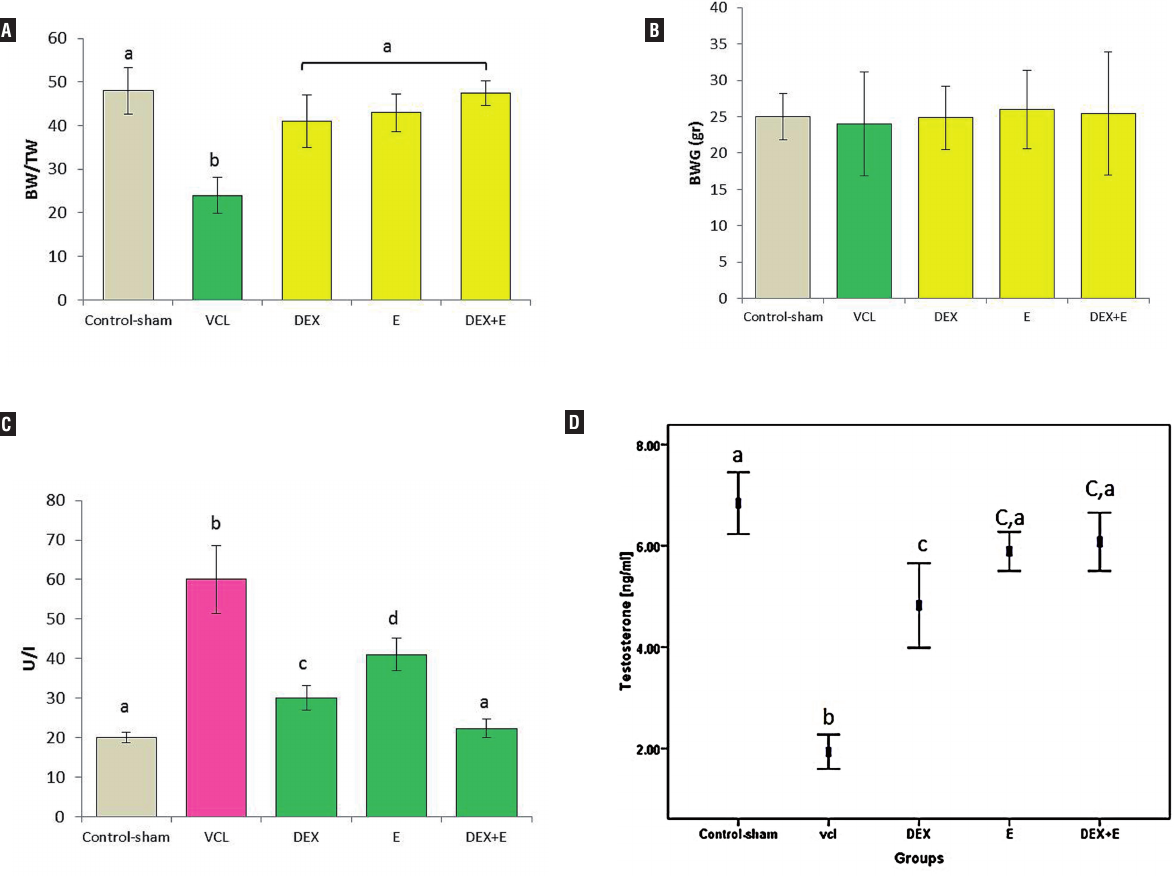
All data are given as Mean±SD (n=6). a,b,c,d : present the significant differences (P<0.05) between differently marked